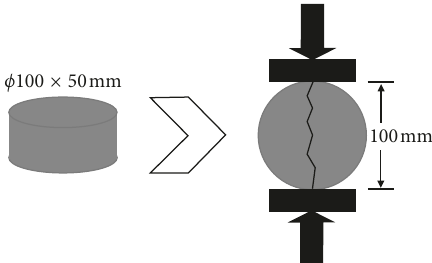
Figure 10: Procedure for the splitting of the specimen.